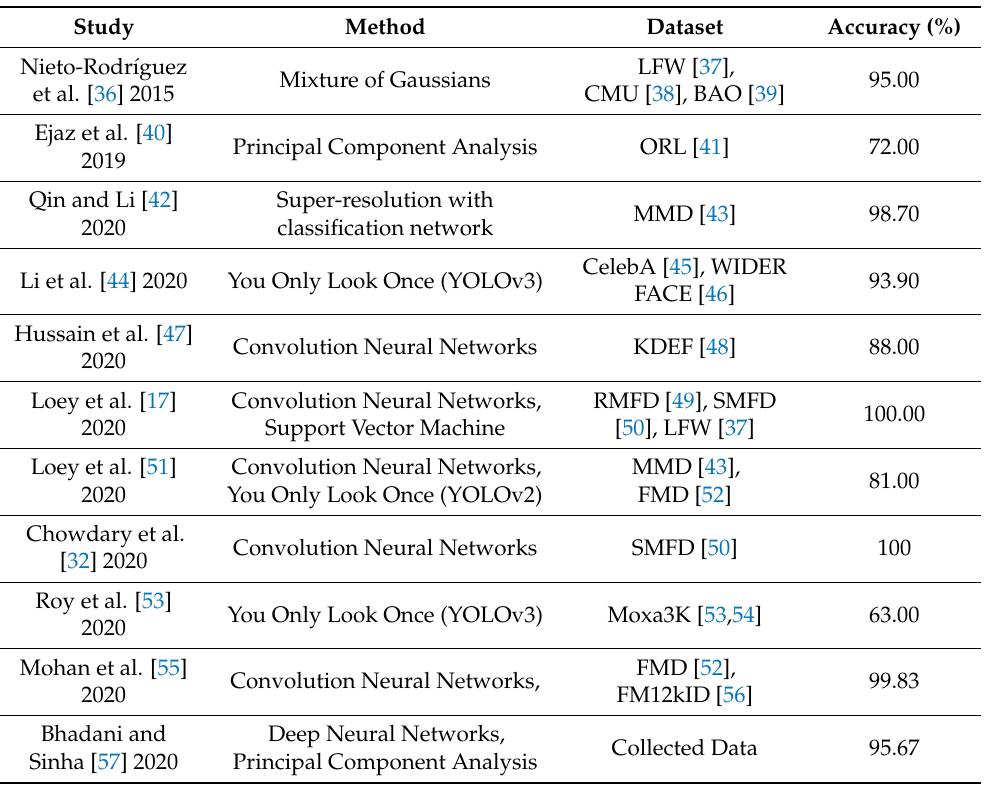
Table 1. Summary of current studies conducted on face mask detection.